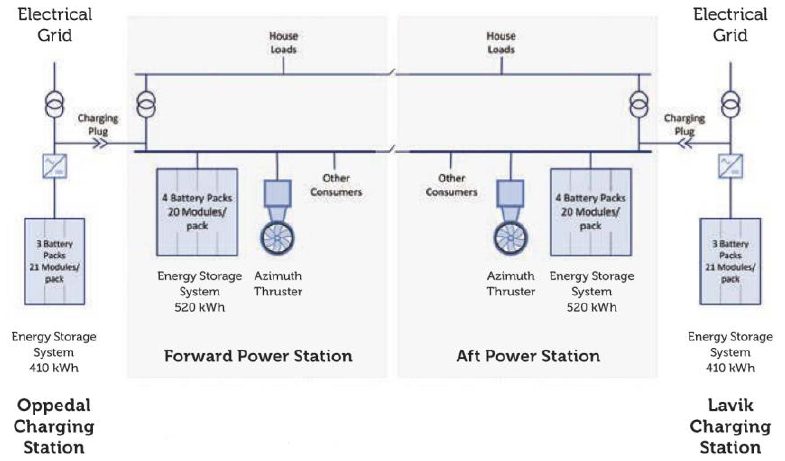
Figure 5. MF Ampere—single line diagram Figure 5. MF Ampere — single line diagram [51].